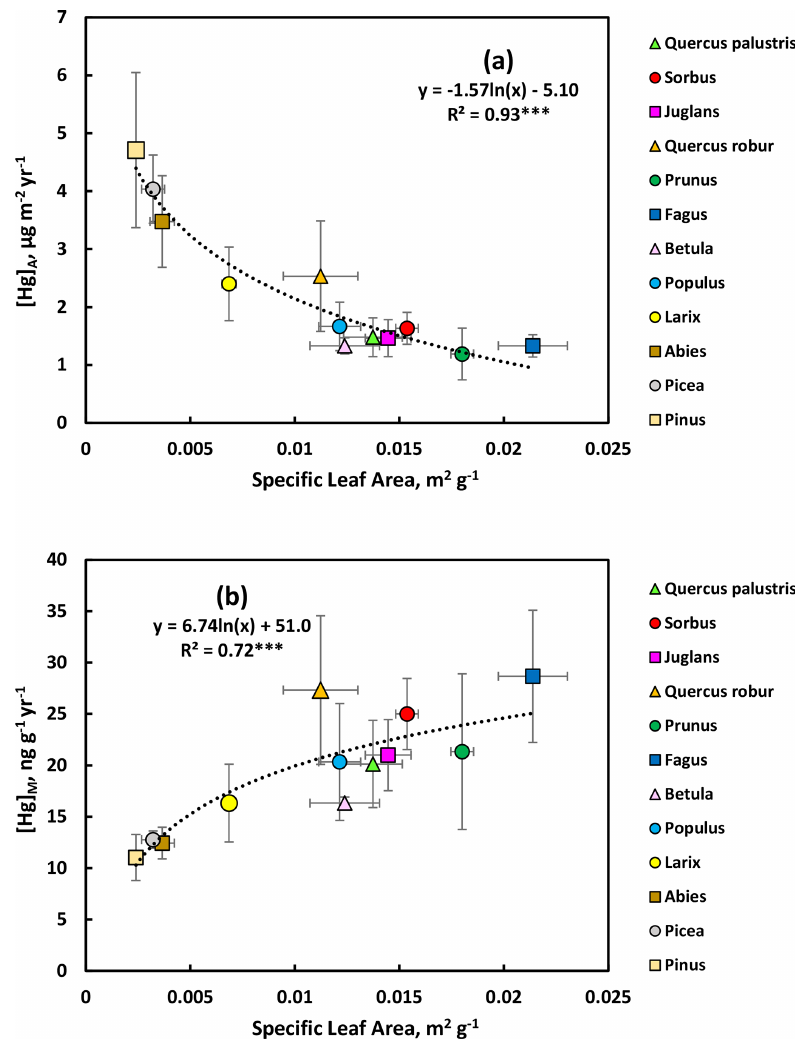
Figure 7. Seasonal accumulation rate of Hg (a) per unit leaf area and (b) per unit dry mass in relation to specific leaf area. Each data point represents the observations for one species. Error bars show the standard